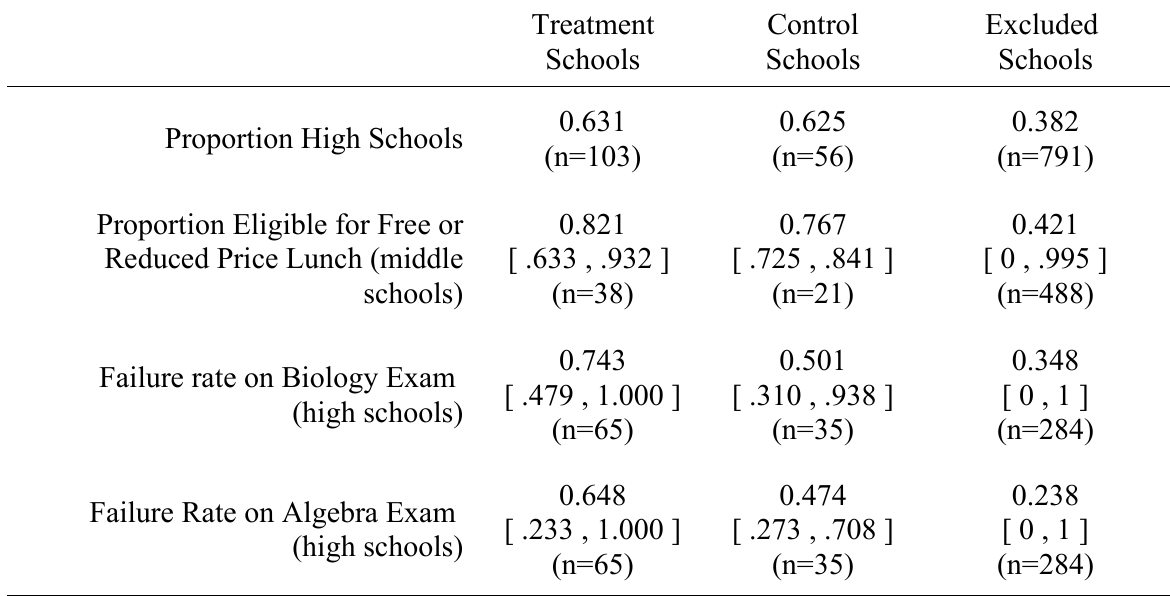
Table 1 : School Level Summary